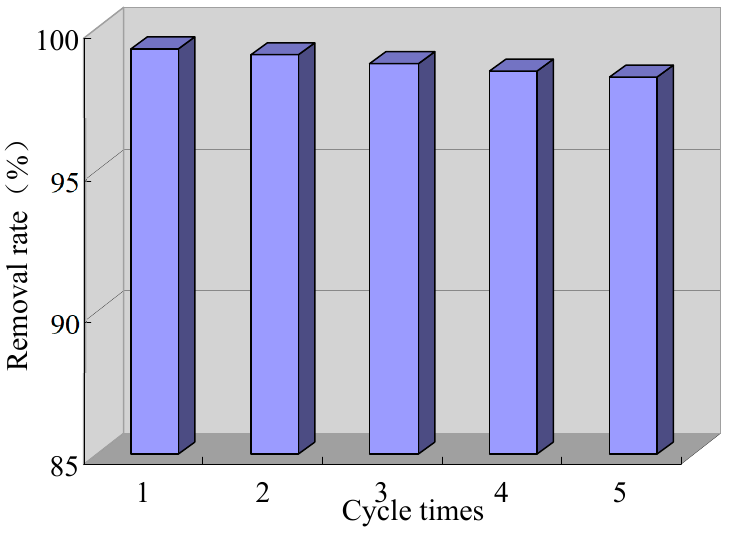
Figure 10. Effect of repeat use of Pd/Ni on the removal of 3-CP.